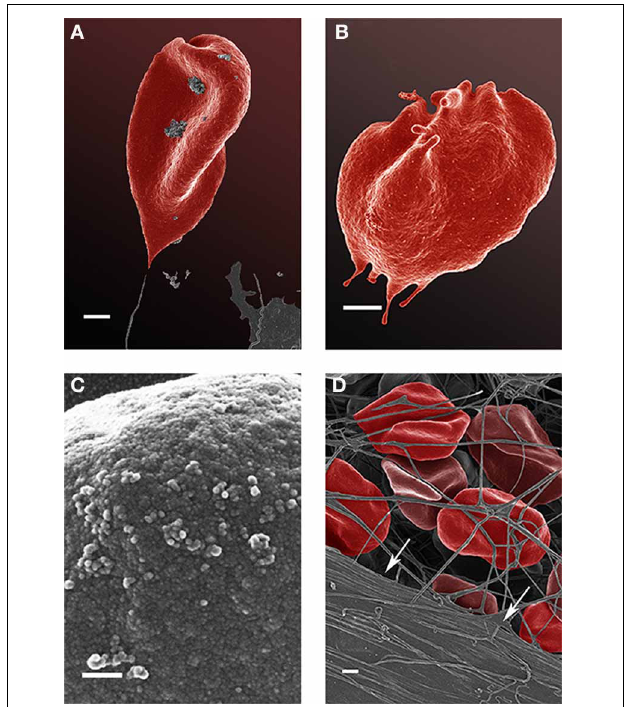
FIGURE 7 | Scanning electron microscopy (SEM) micrographs of a typical high serum ferritin (SF) Alzheimer’s (AD) individual (scale = 1 µ m) (A,B) . High machine magnification (150,000 × ) of a typical RBC membrane from a high serum ferritin (SF) Alzheimer’s (AD) individual (Scale = 100nm) (C) ; red blood cell from a high serum ferritin (SF) Alzheimer’s (AD) individual where thrombin is added to whole blood; the cells loose their discoid shapes and dense matted fibrin deposits are present in the lower left corner of the micrograph (indicated by arrows) (scale = 1 µ m) (D) .